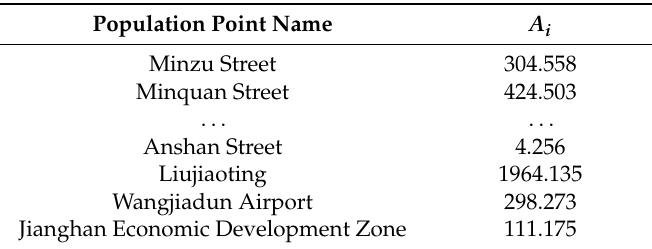
Table 2. Healthcare accessibility indicator of each population